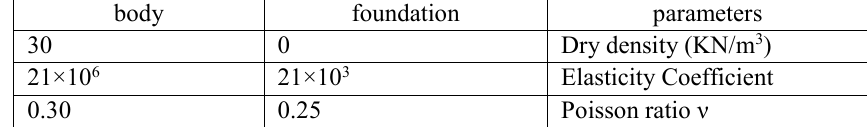
Characteristics of concrete arc dam material. body foundation